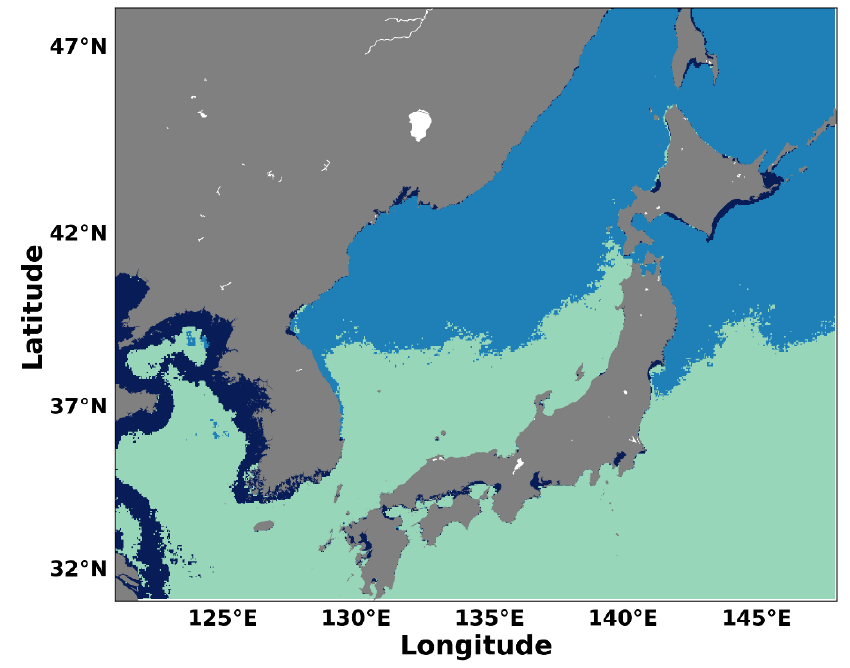
Figure 6. Dominant area of each class. Indigo, blue, and green colors indicate micro-size phytoplankton, nano-size phytoplankton, and pico-size phytoplankton, respectively.